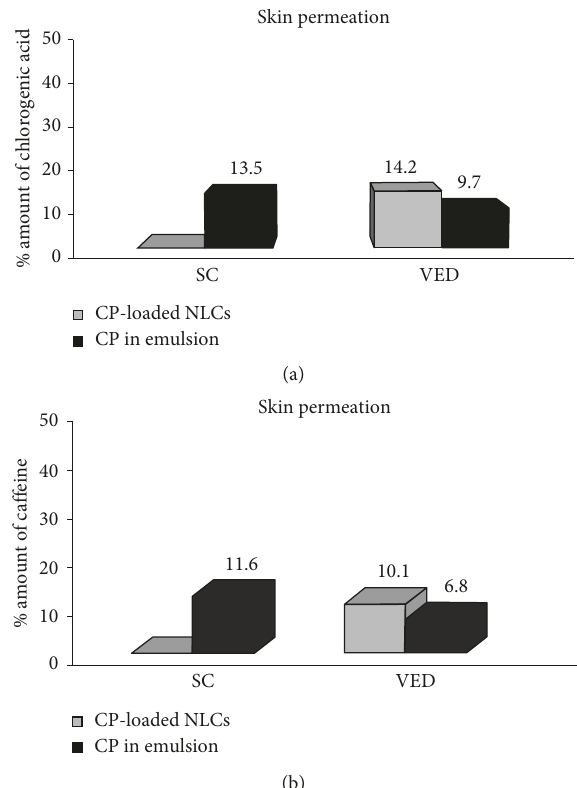
Figure 8: Amount of (a) chlorogenic acid and (b) caffeine in the stratum corneum (SC) and viable epidermis and dermis (VED) after 10 h.